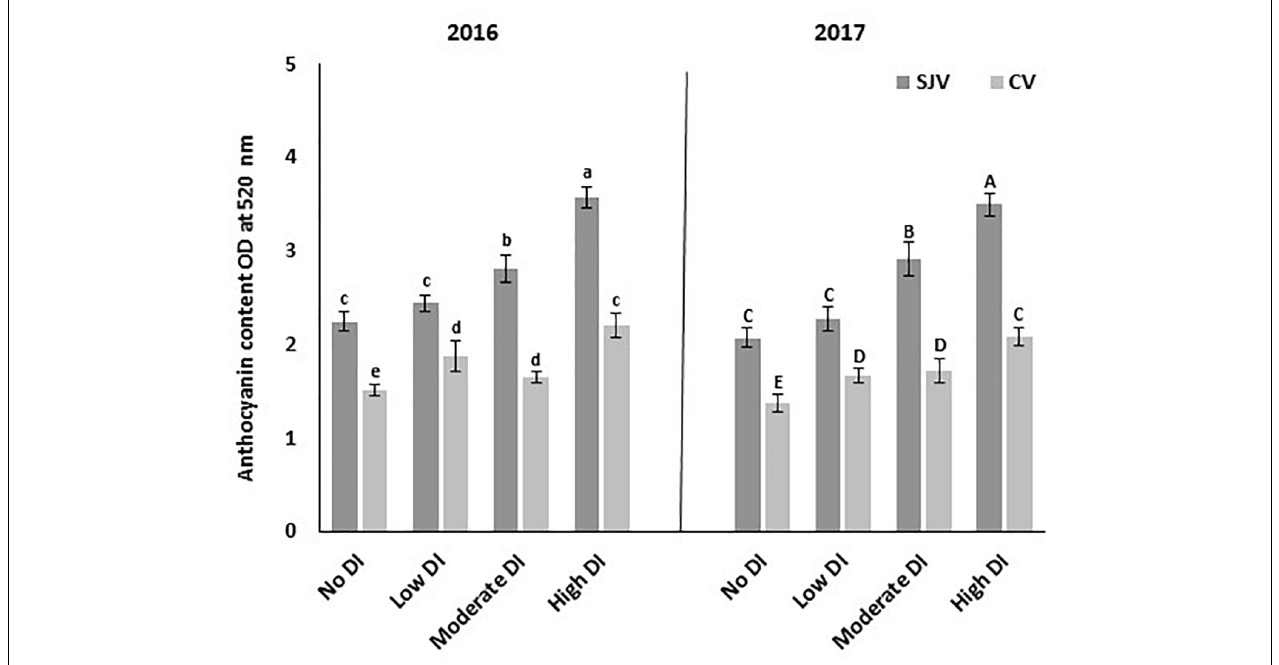
FIGURE 3 | Total anthocyanin contents in Scarlet Royal berry skin at harvest in 2016 and 2017, as affected by different deficit irrigation treatments in San Joaquin Valley (SJV), and Coachella Valley (CV). The data is presented as an optical density (OD) at 520 nm. The error bars represent the standard deviation. Different letters on bars indicate significant differences among treatments and locations at p < 0.05 according to the Tukey HSD test within the same season. Different lower-case letters indicate a significant difference among treatments and locations in 2016 while capital letters are used for